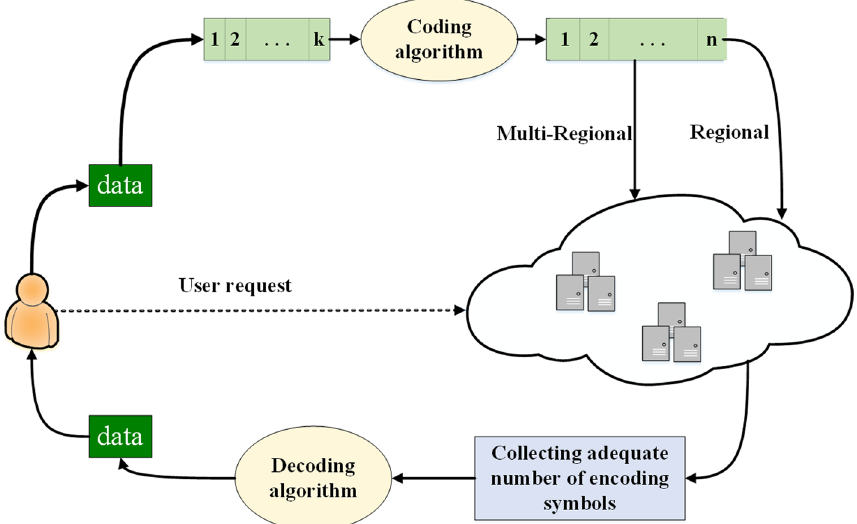
Fig. 3 General structure of our LT code-based cloud